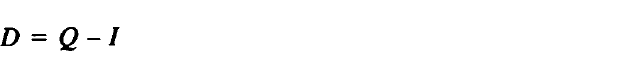
Figure 3 The relationship between interest parity and the quoted dollar premium (Aug 1983 - Aug 1985).